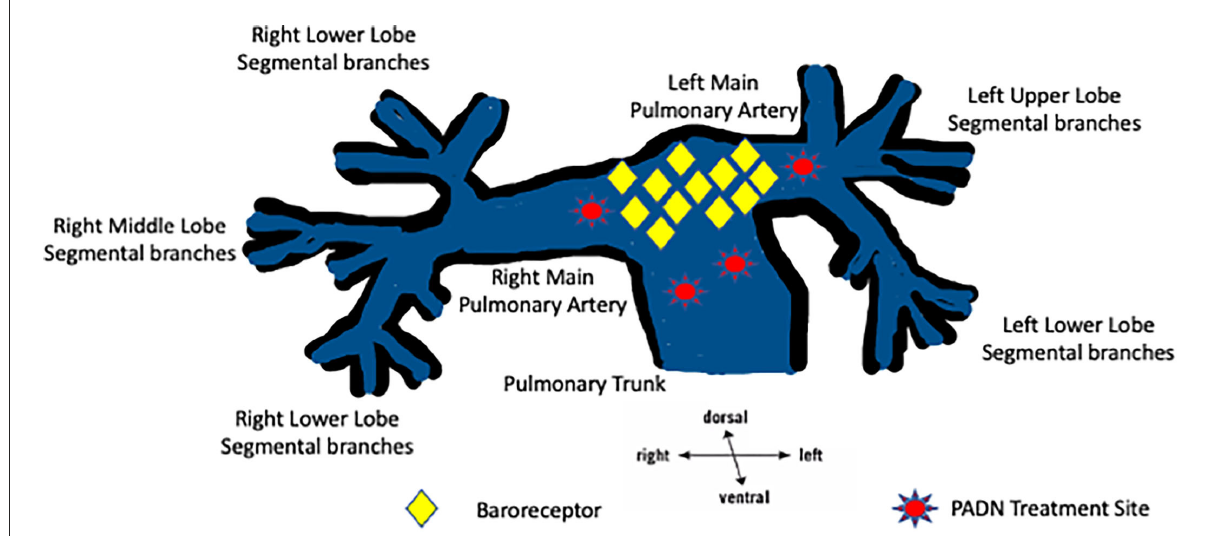
FIGURE1 A graphic of the pulmonary arterial tree showing the common locations of baroreceptors and the current PADN treatment sites in the pulmonary trunk, the pulmonary bifurcation, and the pulmonary